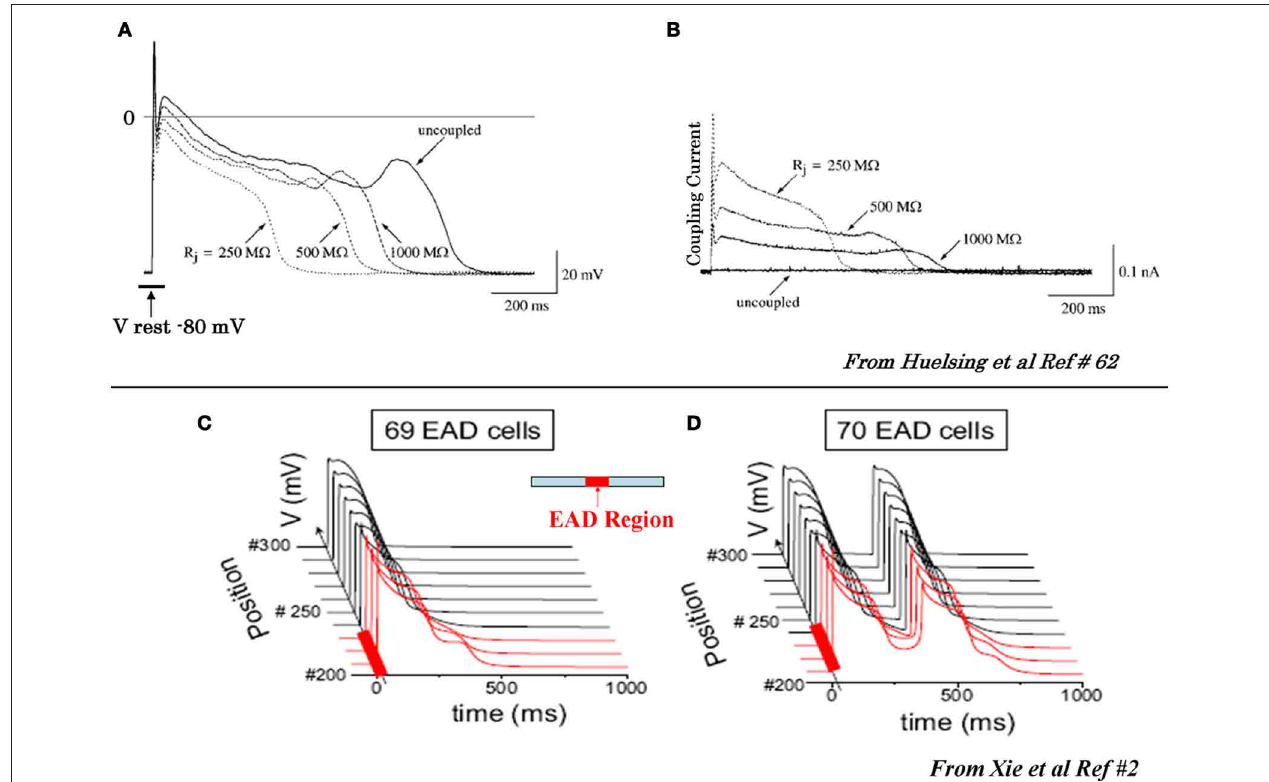
FIGURE 2 | Suppression of EAD by coupling to a cell with no EAD (A) and (B) and initiation of propagating EADs in 1D cable with a critical number of cell synchronously firing EADS (C) and (D). (A) In the uncoupled state (solid traces) the EAD is apparent, however, as the coupling resistance between the EAD cell and the non-EAD cell with a resting potential of − 80mV is progressively reduced the amplitude of the EAD decreases and eventually it is suppressed at coupling resistances > 500MW. (B) Intercellular current flow during coupling of the two cells